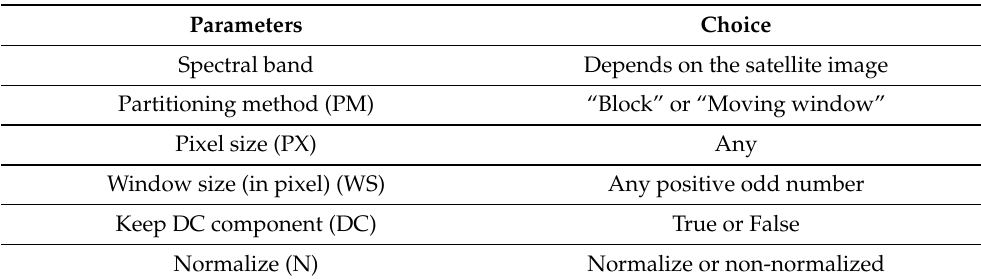
Table 1. The various parameters and possible options to be implemented by the users in the FOTOTEX